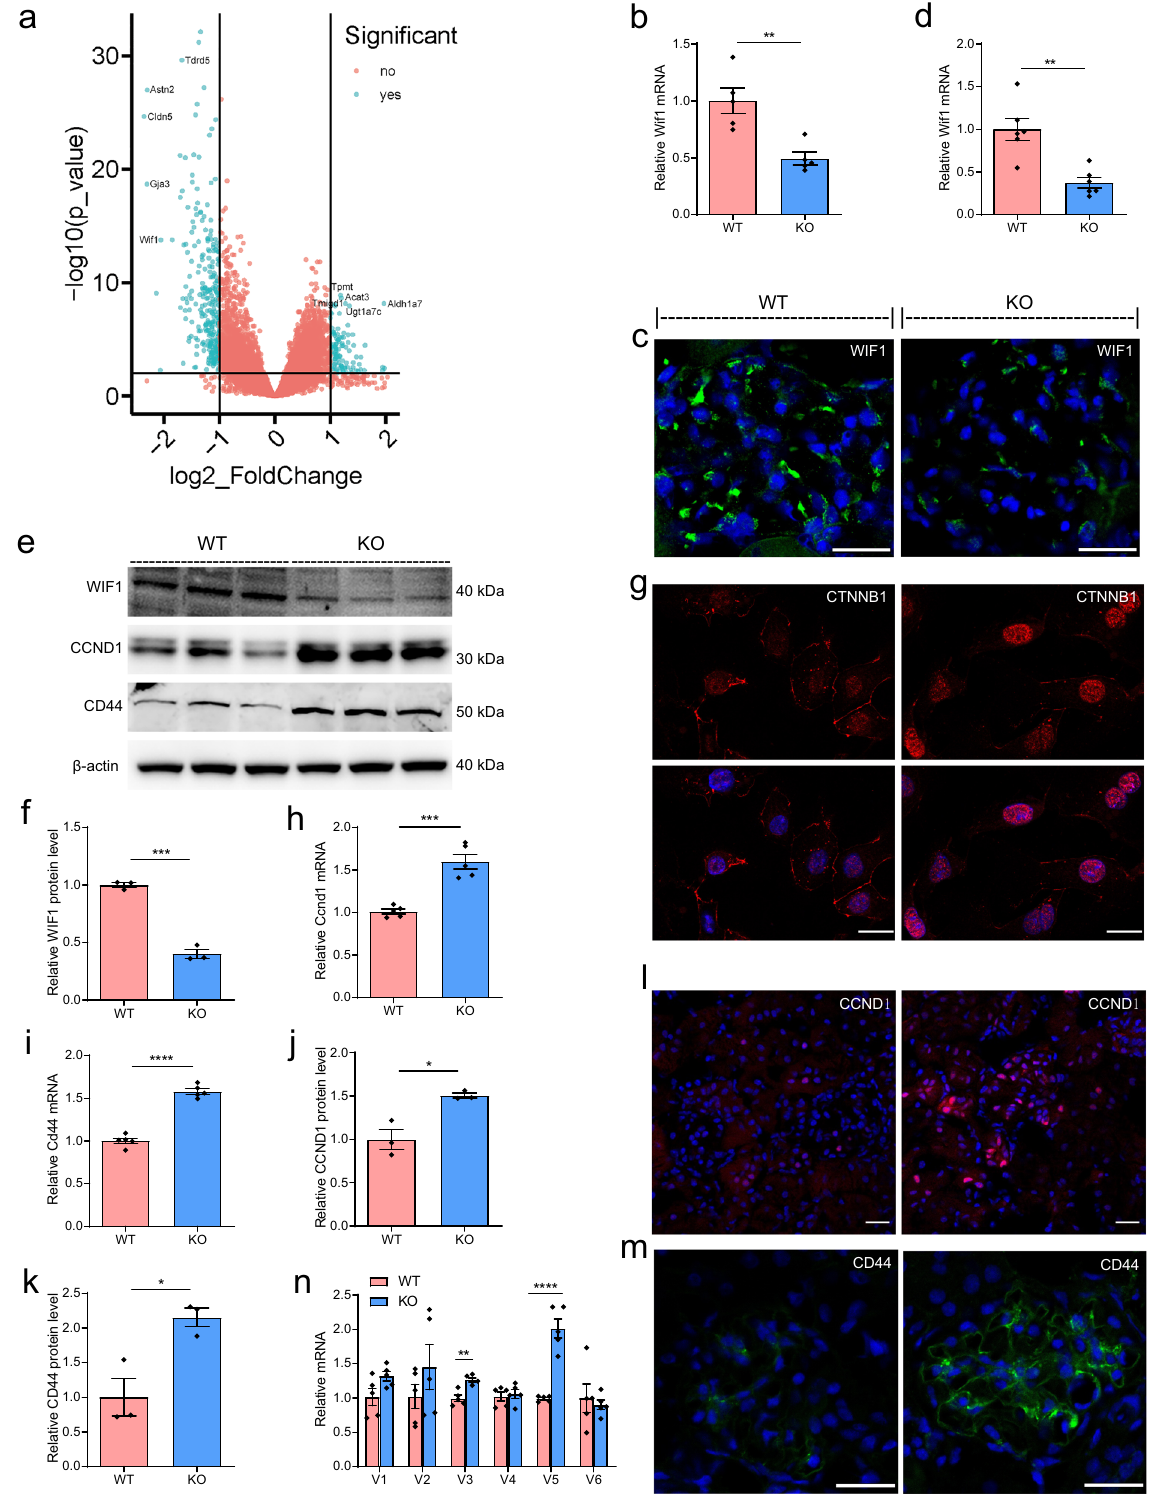
AAV9-mediated WIF1 overexpression in podocytes amelio- rates the progression of DN in podocyte-speci fi c Cldn5 KO mice . To further investigate the relevance of WIF1 to the glo- merular phenotype of Cldn5 podKO mice, we assessed whether podocyte-speci fi c WIF1 overexpression could rescue the pheno- type of Cldn5 podKO mice. To overexpress WIF1 in podocytes,